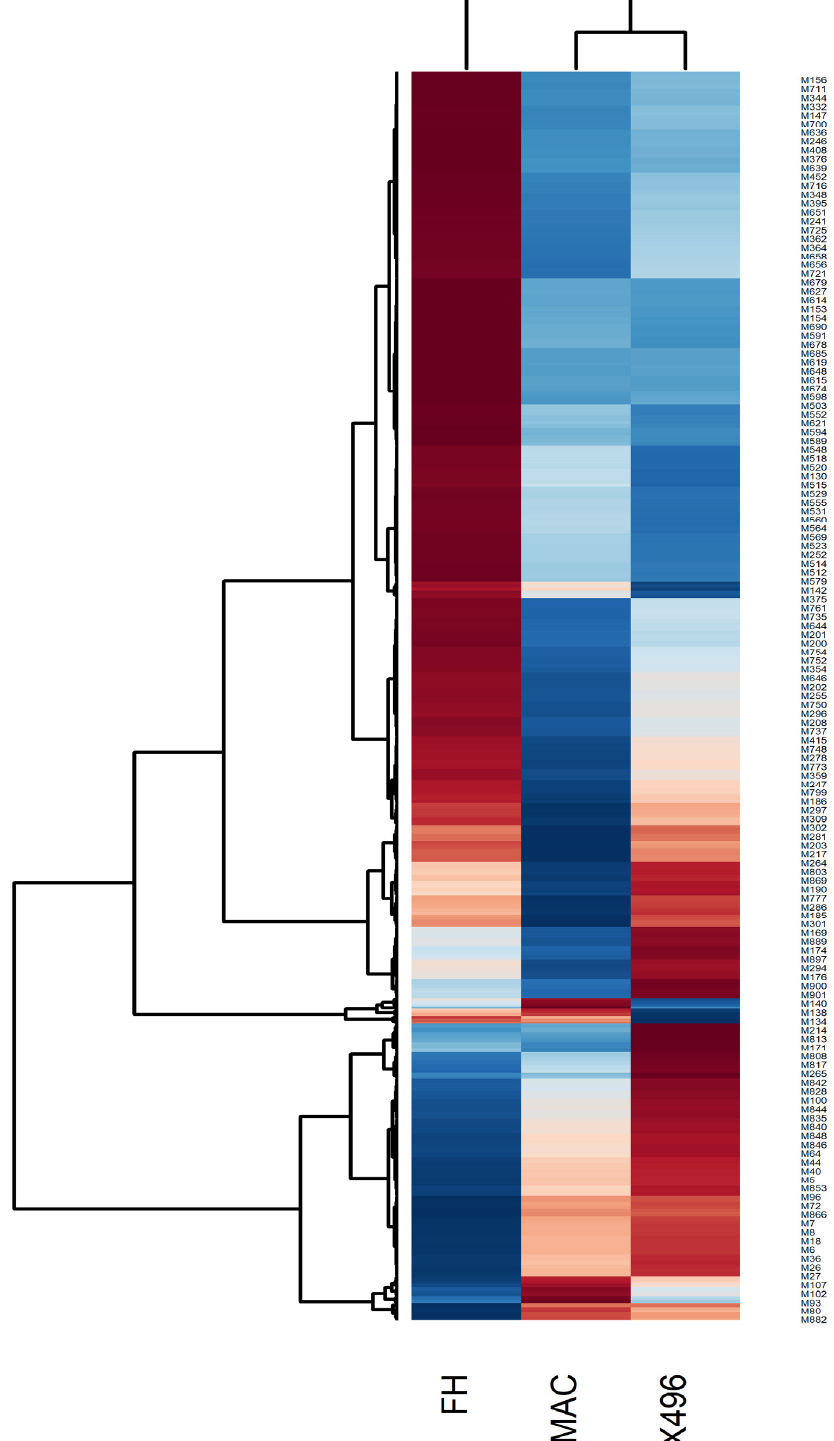
Figure 2. Heat map showing an overall metabolite content in cotton varieties. M376 refers to Arabinose M716 to tyrosine, M348 to tryptophan, M241 to succinic acid, M648 to cinnamic acid, M674 to E- β -ocimene, M515 to maltose, M512 to stigmasterol, M200 to linoleic acid, M646 to fumarate, M296 to GABA, M278 to di-allylic methylene, M186 to limonene respectively. Red color shows an increased expression level while blue color displays decreased expression level. Hierarchical classification was performed to group metabolites from each group. Dendrograms show clustering between metabolites which were closely related based on their estimated Euclidean